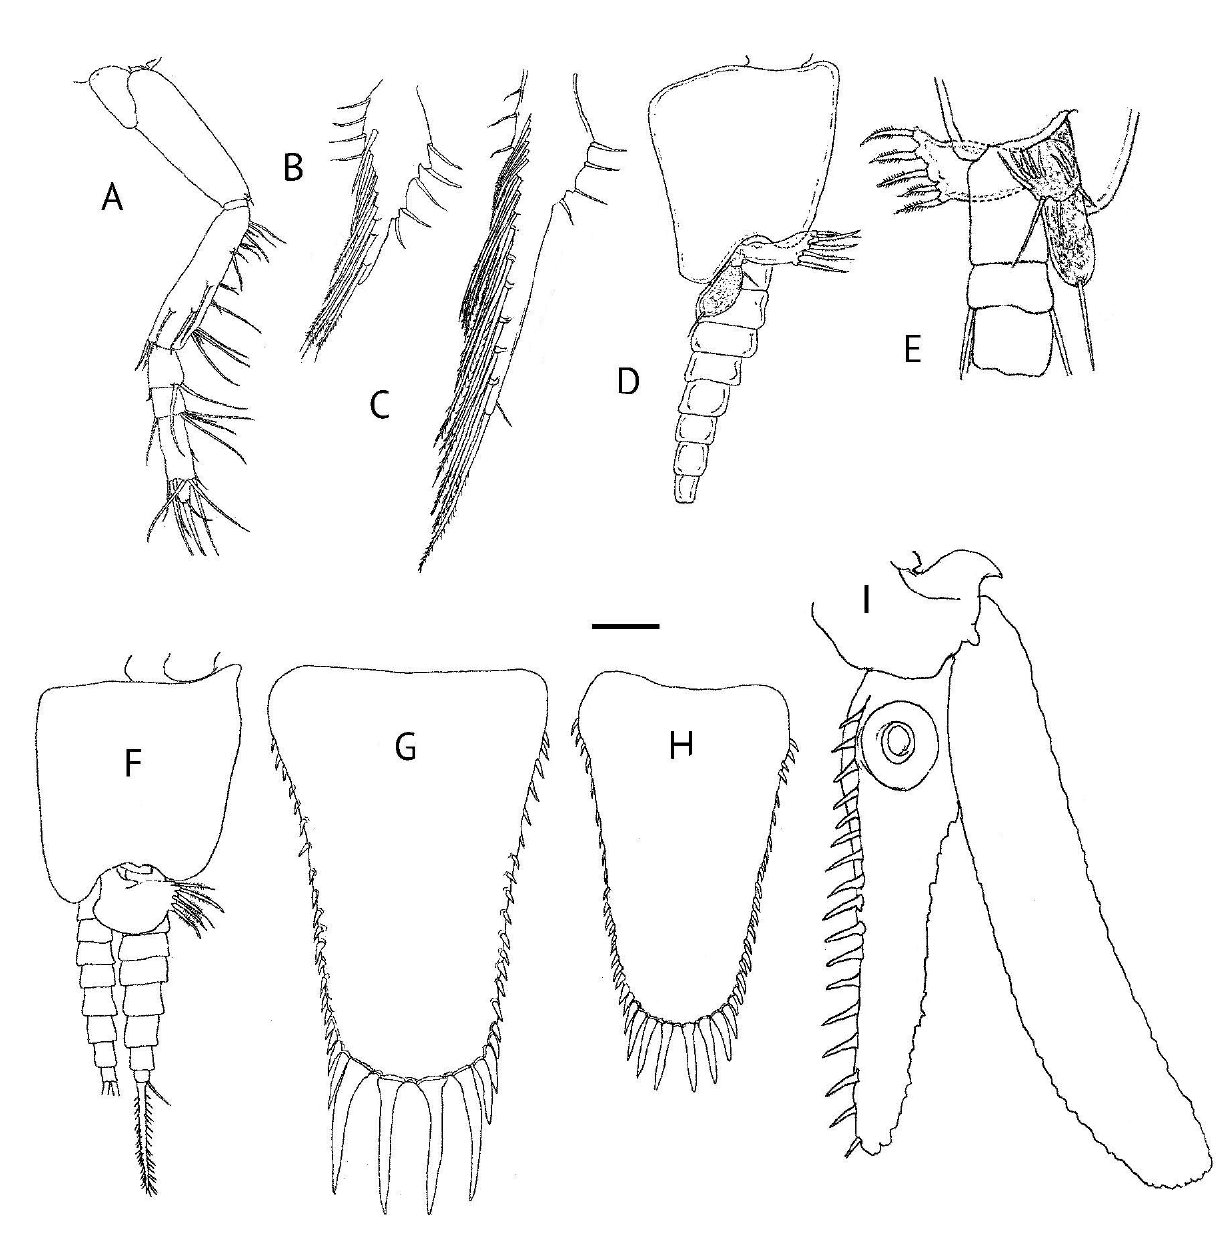
Figure 3. Mysidopsis gemina n. sp., adult female (B, C, G), male (A, D–F, H, I). A, thoracic endopod 8; B, pleopod 4, anterior view; C, pleopod 5, anterior view; D, pleopod 1, posterior view; E, pleopod 1, anterior view; F, pleopod 4, posterior view; G, telson; H, telson; I, uropod. Scale: A–D, F–I, 0.1 mm; E, 0.05